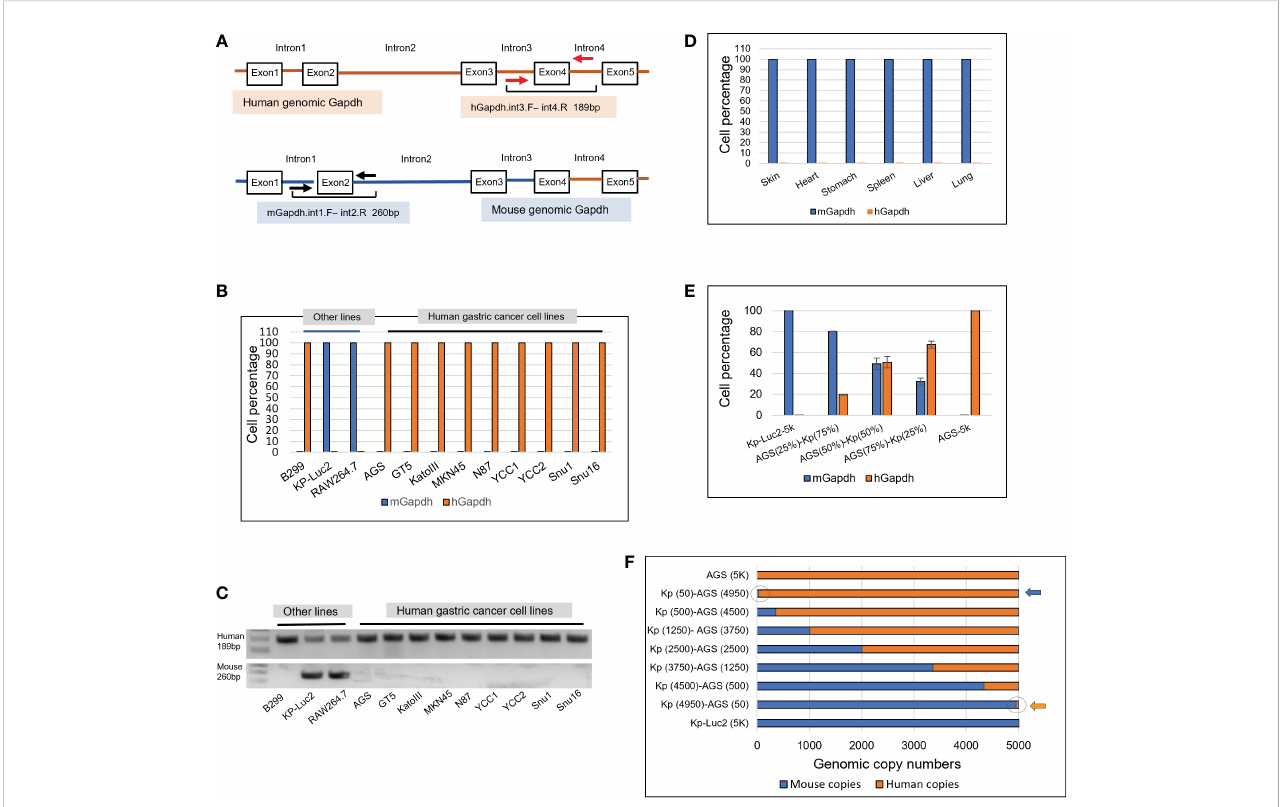
FIGURE 1 Design of intronic qPCR primers on genomic Gapdh gene and its quanti fi cation on human and murine genomic Gapdh copies as well as tests of ampli fi cation ef fi cacy and sensitivity. (A) A schematic diagram of the genomic human and murine Gapdh gene (hGapdh and mGapdh) shows the locations of two sets of intronic qPCR primers. (B) Intronic qPCR method was applied to authenticate gastric cancer and other cell lines. (C) qPCR end products corresponding to B were visualized on agarose gels, showing human amplicon 189bp and murine 260bp. (D) Intronic qPCR quanti fi cation was tested on organs of a SCID mouse. (E) Ef fi ciency test of qPCR quanti fi cation of hGapdh and mGapdh in different combinations of copy numbers, using human cell line AGS and murine line Kp-Luc2. (F) Sensitivity test of qPCR quanti fi cation of copy numbers using the same two lines as in E, arrows pointed to the circles where 50 copies of human genome and murine genome were